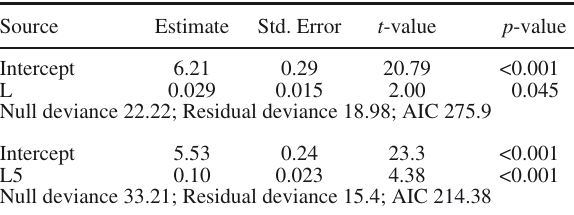
Table 2. – Results of GLM for the total catch (May and June cu- mulated) and for May (below), under the effect of Mistral wind with the intensity ≤ 15